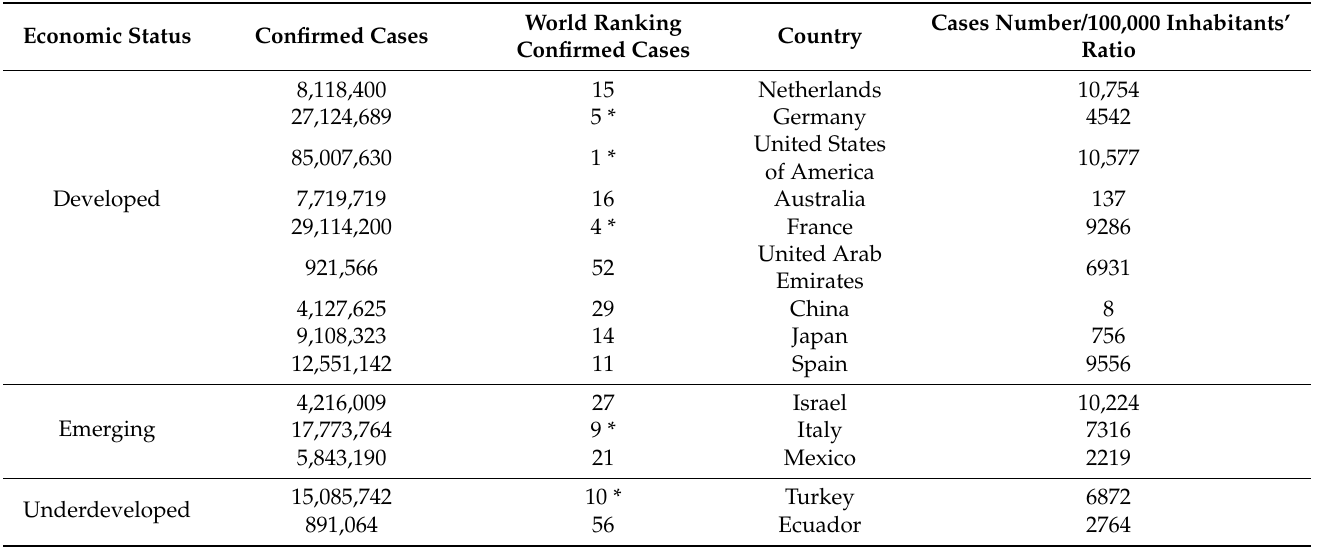
Table 2. Countries where evidence of SARS-CoV-2 was found in wastewater and confirmed cases of COVID-19 and world